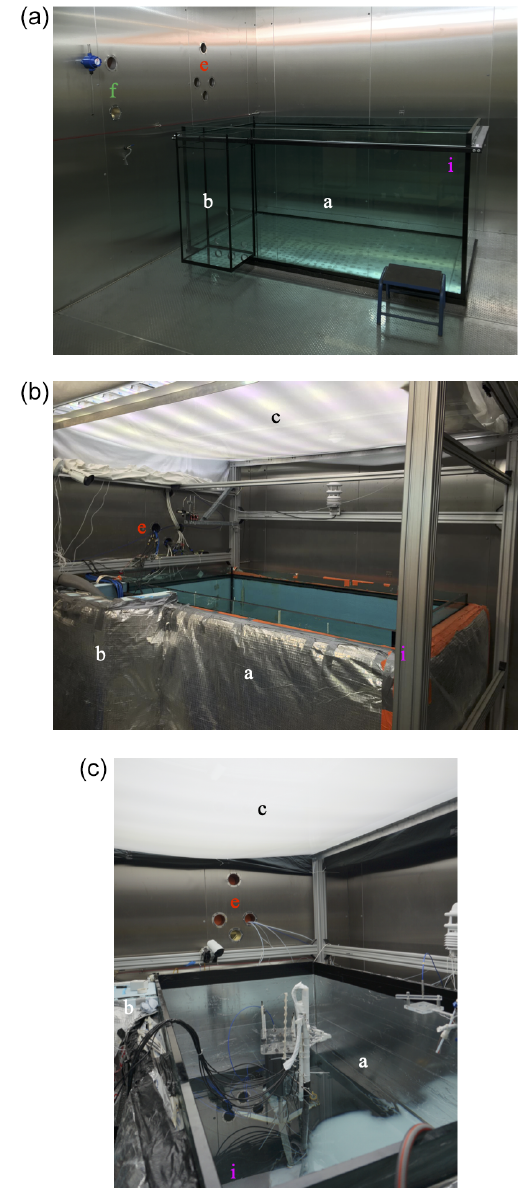
Figure 1. The tank just after installation (a) , with all the main fea- tures in place (b) , and set up for experiments with visible lighting (c) . The labels are consistent with Fig. 3, indicating: a the main tank, b the side tank, c the lights, e atmosphere sample lines and cables, f ocean sample lines and cables, and i the (0, 0) position of our sampling coordinate